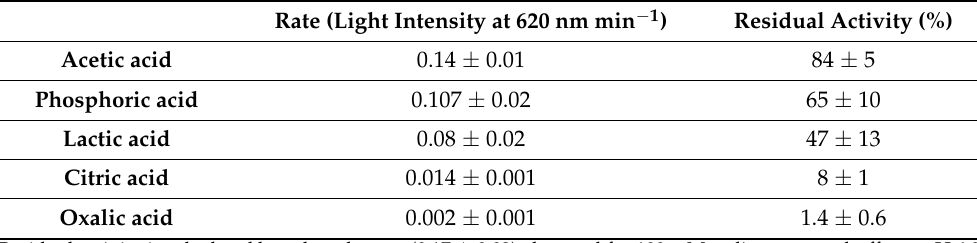
Table 4. Rates obtained for Nc LPMO9C by the turbidity assay in the presence of different